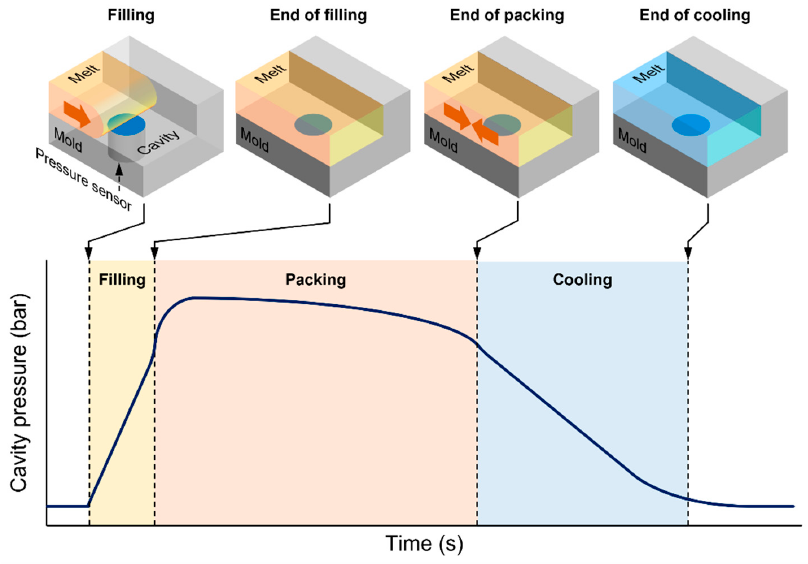
Figure 1. Typical injection ‐ molding cavity pressure profile and process stages. Machine learning has been used for quality prediction and optimization of injection ‐ molding processes [19]. It requires less prior experience and knowledge to model relation ‐ ships in the injection ‐ molding process. Building a training dataset of the injection molding process is expensive and time ‐ consuming. Ozcelik and Erzurumlu pointed out that the orthogonal array used for Taguchi method requires the minimum time and resources to get the information about the design parameters [22]. Oliaei et al. also indicated that or ‐ thogonal array is an efficient method for DOE [23]. Therefore, many researchers used an orthogonal array to build a training dataset [24]. Computer simulations have been pro ‐ posed as a substitute for physical experiments or to build pre ‐ trained models for transfer learning. Li et al. and Guo et al. applied genetic algorithm for neural network trained by moldflow simulation result to reduce warpage [25,26]. Shi et al. applied parametric eval ‐ uation strategy on artificial neural network trained by simulation result to optimize mold ‐ ing process [27]. Tercan et al. built a pre ‐ trained model by the simulation result and ap ‐ plied transfer learning to the pre ‐ trained model [28]. Lee et al. developed the process con ‐ dition recommendation system using a pre ‐ trained neural network model [29]. Process parameters have been used for optimization using the machine learning. Tsai and Luo selected mold temperature, cooling time, and packing time to be optimized [30]. Changyu et al. applied genetic algorithms on mold and melt temperature, injection and placing time, and holding pressure to optimization [31]. However, the process parameters on the machine side are not sufficient for optimization [9]. Therefore, it is desirable to make use of in ‐ mold sensor signals with machine learning technology for optimizing injection ‐ molding processes. In this study, a novel analysis methodology for cavity pressure profiles is proposed. Process state points (PSPs) are extracted to represent the features of the molding condi ‐ tions in the cavity. A simple neural network is trained to correlate the PSPs and part weight as a quality index. The trained neural network is interpreted to analyze the impact of each PSP on the part weight. The most influential PSPs are selected, and their impact are compared with the ANOVA results for process parameters to check the validity of the proposed methodology. The proposed methodology contributes to the systematic moni ‐ toring and optimization of injection ‐ molding processes. 2. Methodology